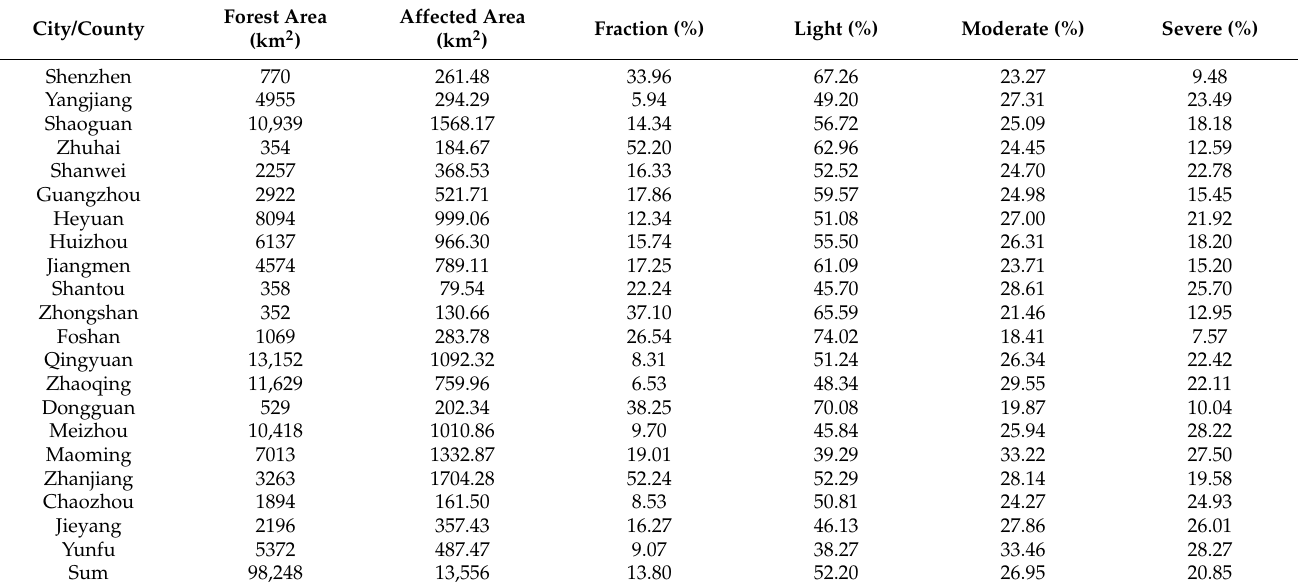
Table 4. The affected forest area and proportions of different damage severities in cities or counties of Guangdong